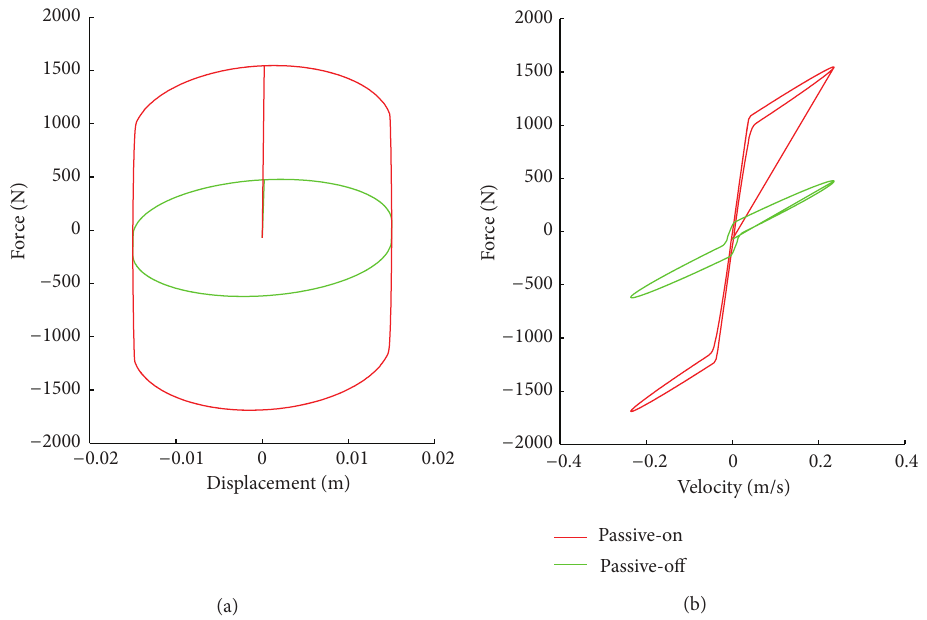
Figure 5: Simulated damper’s force for a harmonic displacement input (sine wave with an amplitude of 0.015 m and a frequency of 2.5 Hz): (a) force versus displacement and (b) force versus